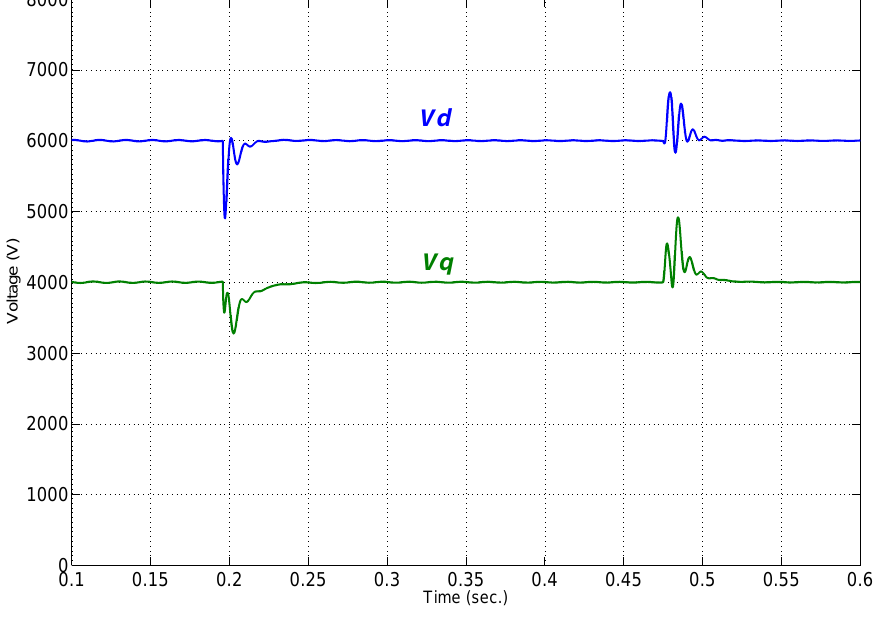
Figure 15. The d and q components of the load voltage generated by the Matlab/simpowersystems.